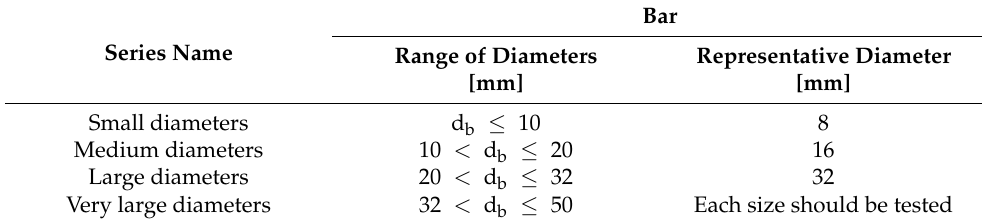
Table 1. Series of bar diameters for pull-out test acc.